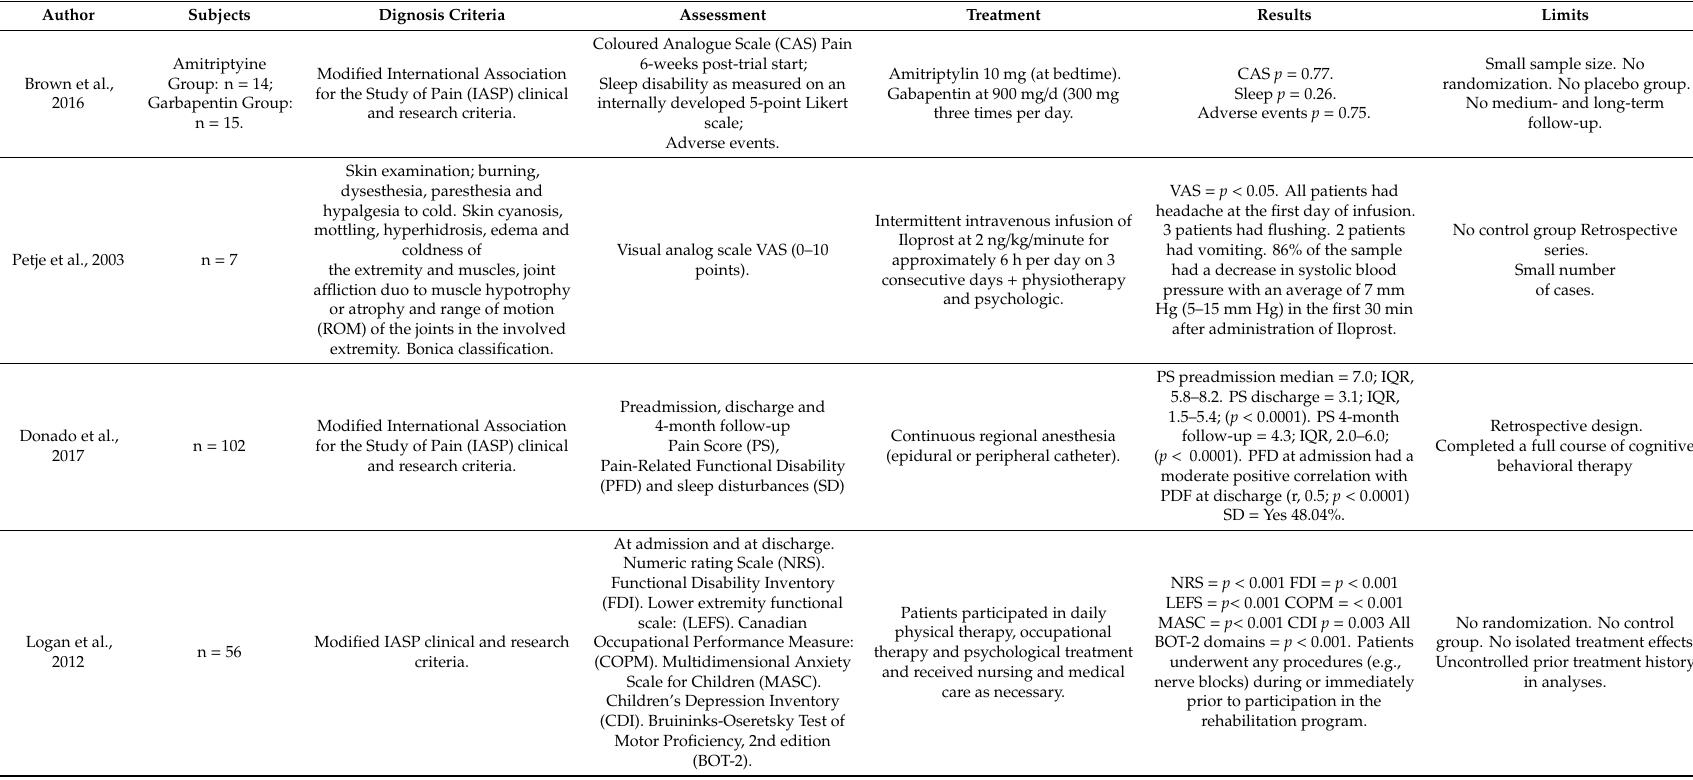
Table 1. Results of selected